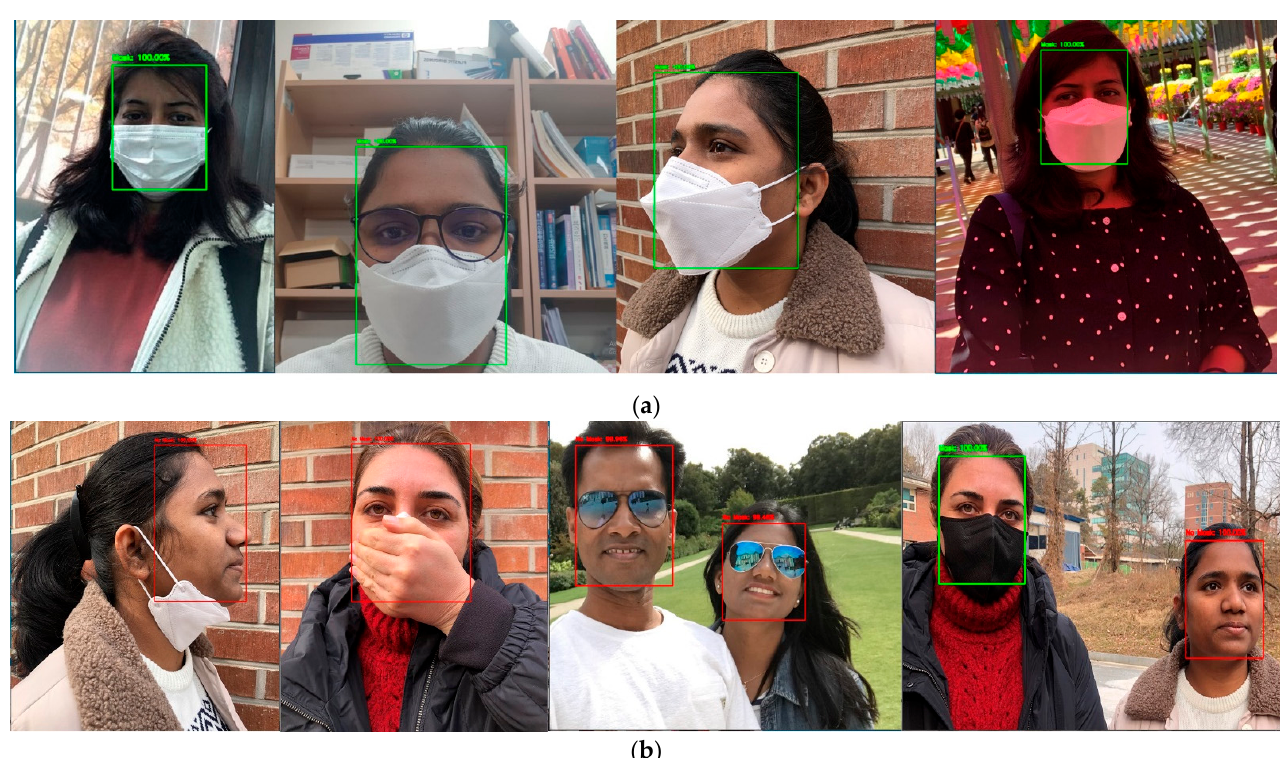
Figure 5. ( a ) Real-time face mask detection from different viewpoints. ( b ) Real-time face detection without a mask, capable of detecting the incorrect position of the mask and identifying it as “without mask”.